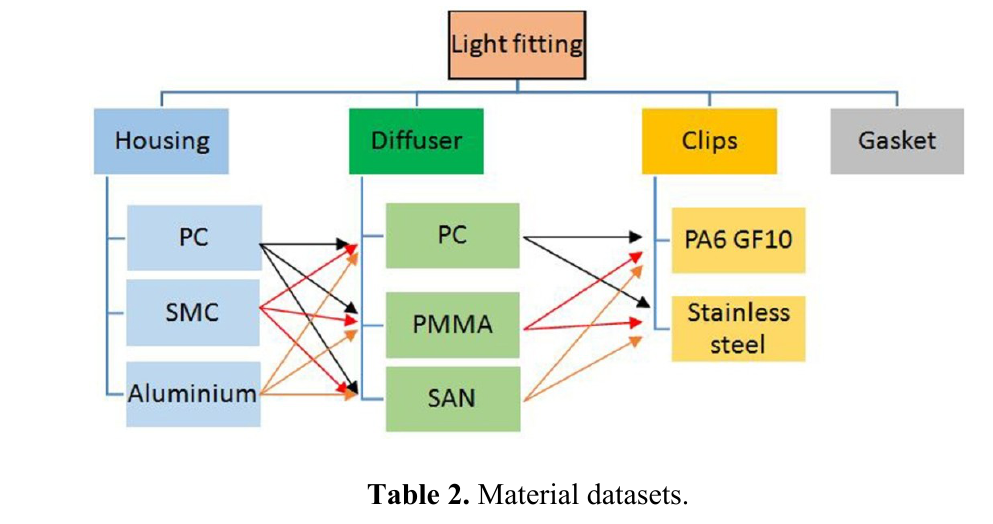
Figure 4. Design combinations.